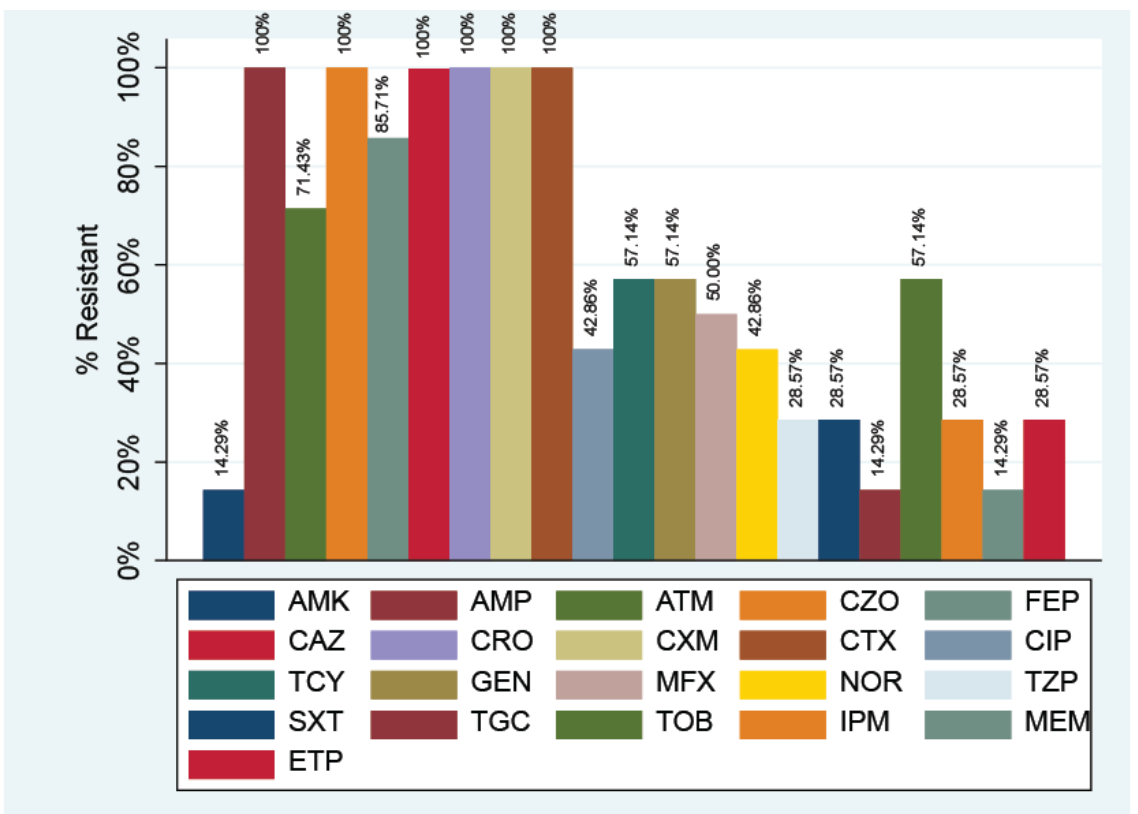
Figure 1. Resistance of E. coli strains to various antibiotics. (AMP: Ampicillin; AMK: